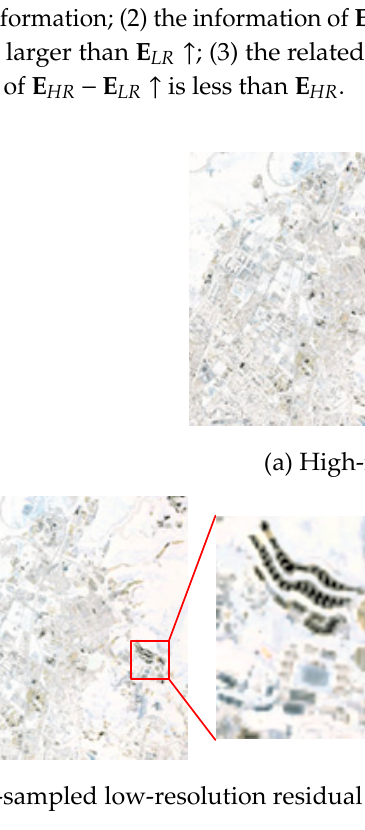
Figure 4. Visual residual matrix after linear fitting, where ( a ) is the high-resolution residual matrix, written as E HR , ( b ) is the up-sampled low-resolution residual matrix, written as E LR ↑ , and ( c ) is the di ff erence between ( a ) and ( b ), written as E HR − E LR ↑ . Table 3. The root mean square (RMS) of residual matrices.